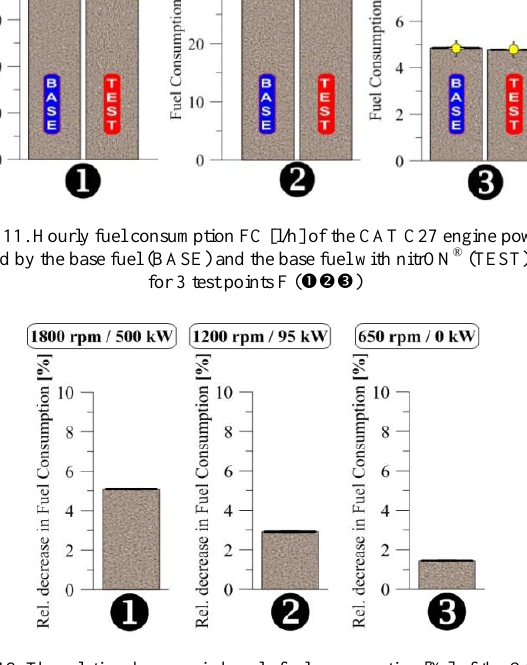
Fig. 12. The relative decrease in hourly fuel consumption [%] of the CAT C27 engine powered by the base fuel (BASE) and the base fuel with nitrON ® (TEST), for 3 points of test F ( 